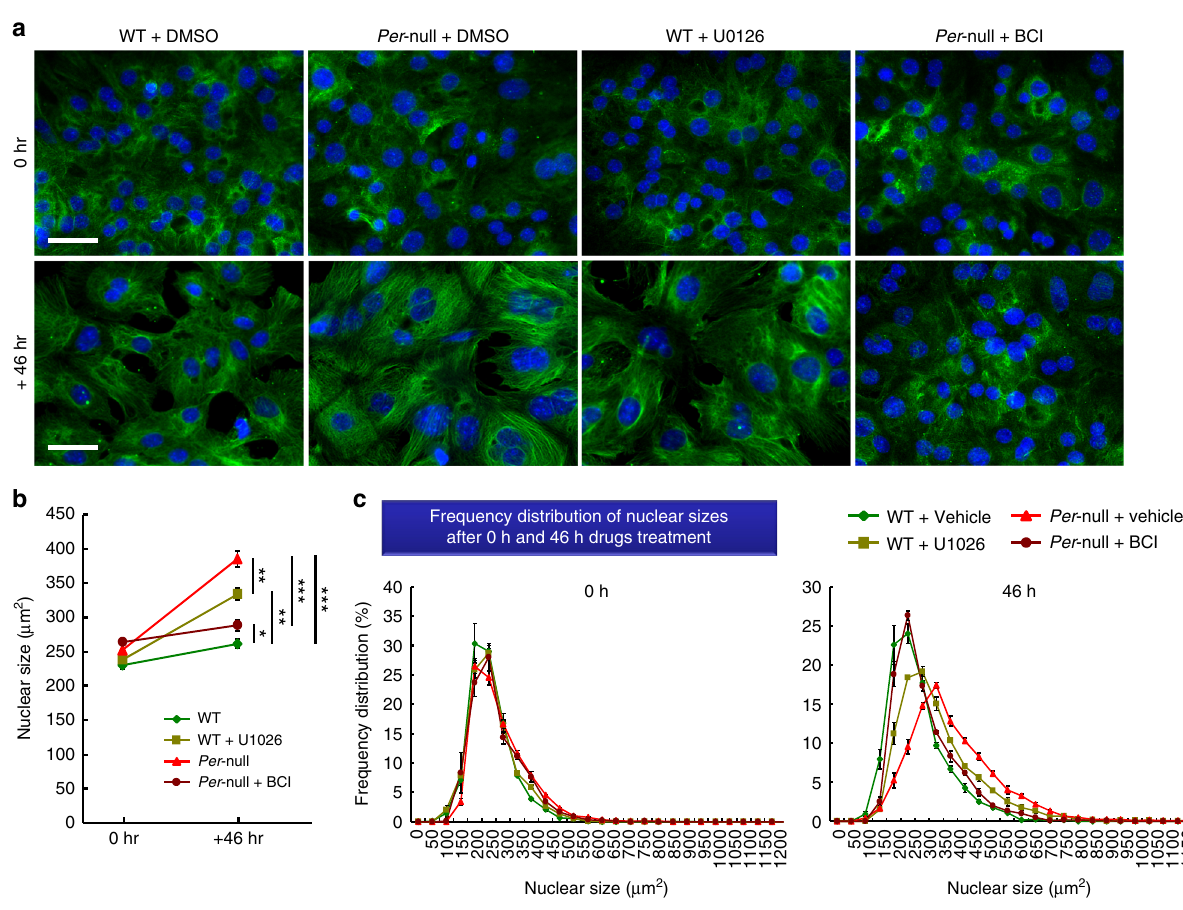
Fig. 6 Pharmacological manipulations change the nuclear size of hepatocytes in culture. a Representative photos showing size change of nucleus after the treatment of Mek inhibitor (U0126) or Mkp1 inhibitor (BCI). Nuclei were stained blue with Hoechst-33342 (blue). Counterstained with tubulin (green). b Quanti fi cation of the alternation of nuclear size between 0 h or 46 h of treatment. Note that Mek inhibitor (U0126) treatment increases the nuclear sizes of WT hepatocytes to those in polyploidy Per -null mice. In contrast, Mkp1 inhibitor (BCI) reduced the nuclear sizes of Per -null hepatocytes to those in WT mice. c Frequency distribution of nuclear size of hepatocytes after 0 h and 46 h drug treatment. Data are representative of at least three independent experiments. Values are the mean ± SEM by Two-way ANOVA with Bonferroni ’ s post-test., n > 3000 cells (three experiments). * P < 0.05, ** P < 0.01, *** P < 0.001. Scale bar, 100 μ quanti fi cation, at least fi ve different fi elds of the microscope were selected ran- domly from each mouse liver. Approximately 1500 to 3000 hepatocytes were analyzed for each animal. Mono- and binucleated hepatocytes were distinguished by comparing Hoechst-33342 and membrane-labeling images.